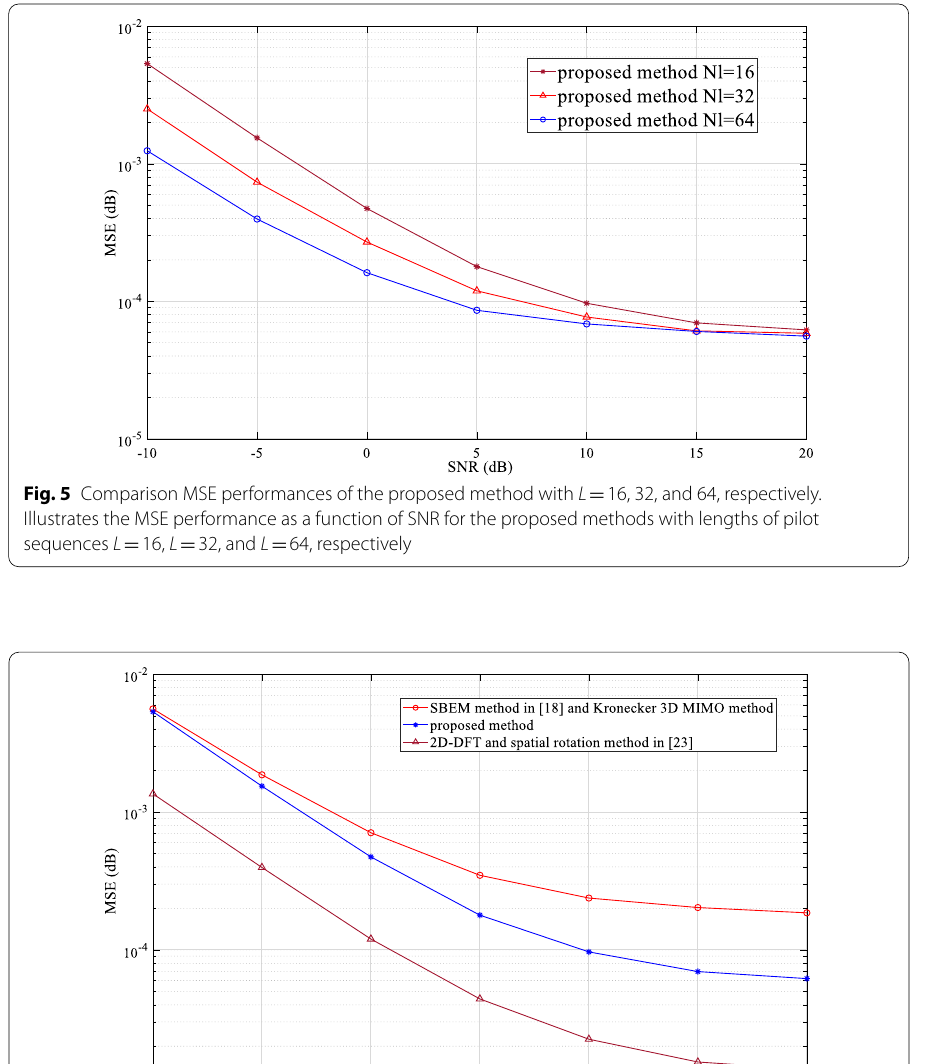
Fig. 6 Uplink MSE performances of proposed method as a function of SNR. Compares the performance of the proposed method with the channels projected onto the x - and y -directions are processed separately using the SBEM method in [18] then generating a 3D MIMO channel by Kronecker product, and method of 2D-DFT and angular rotation technique in